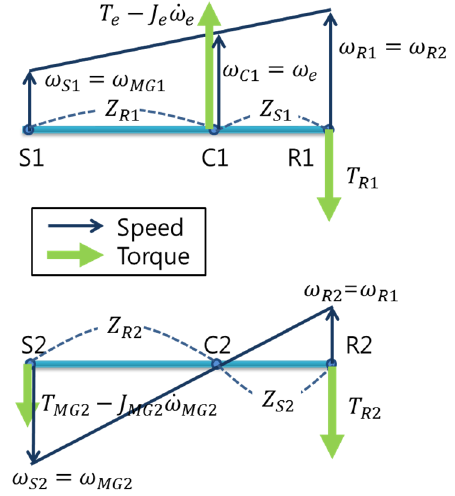
Figure 2. Lever analysis of the planetary gear for speed and torque.